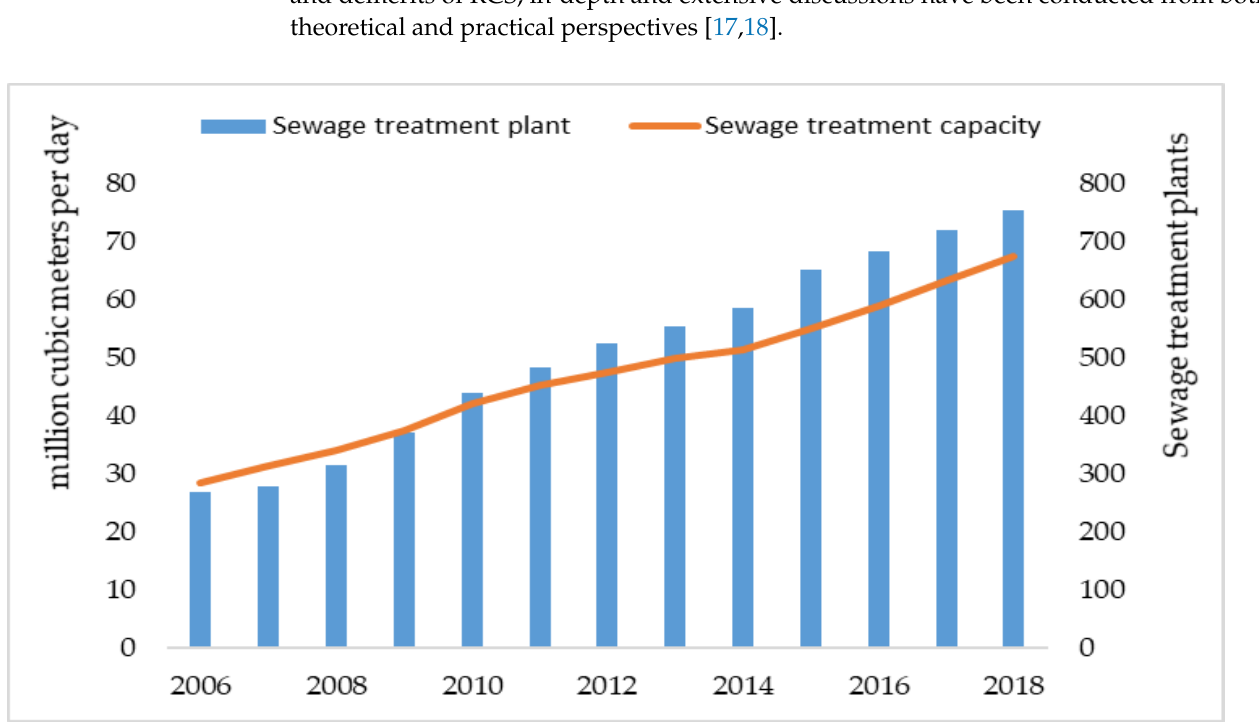
Figure 1. Sewage treatment plants and capacity changes (2006–2018).